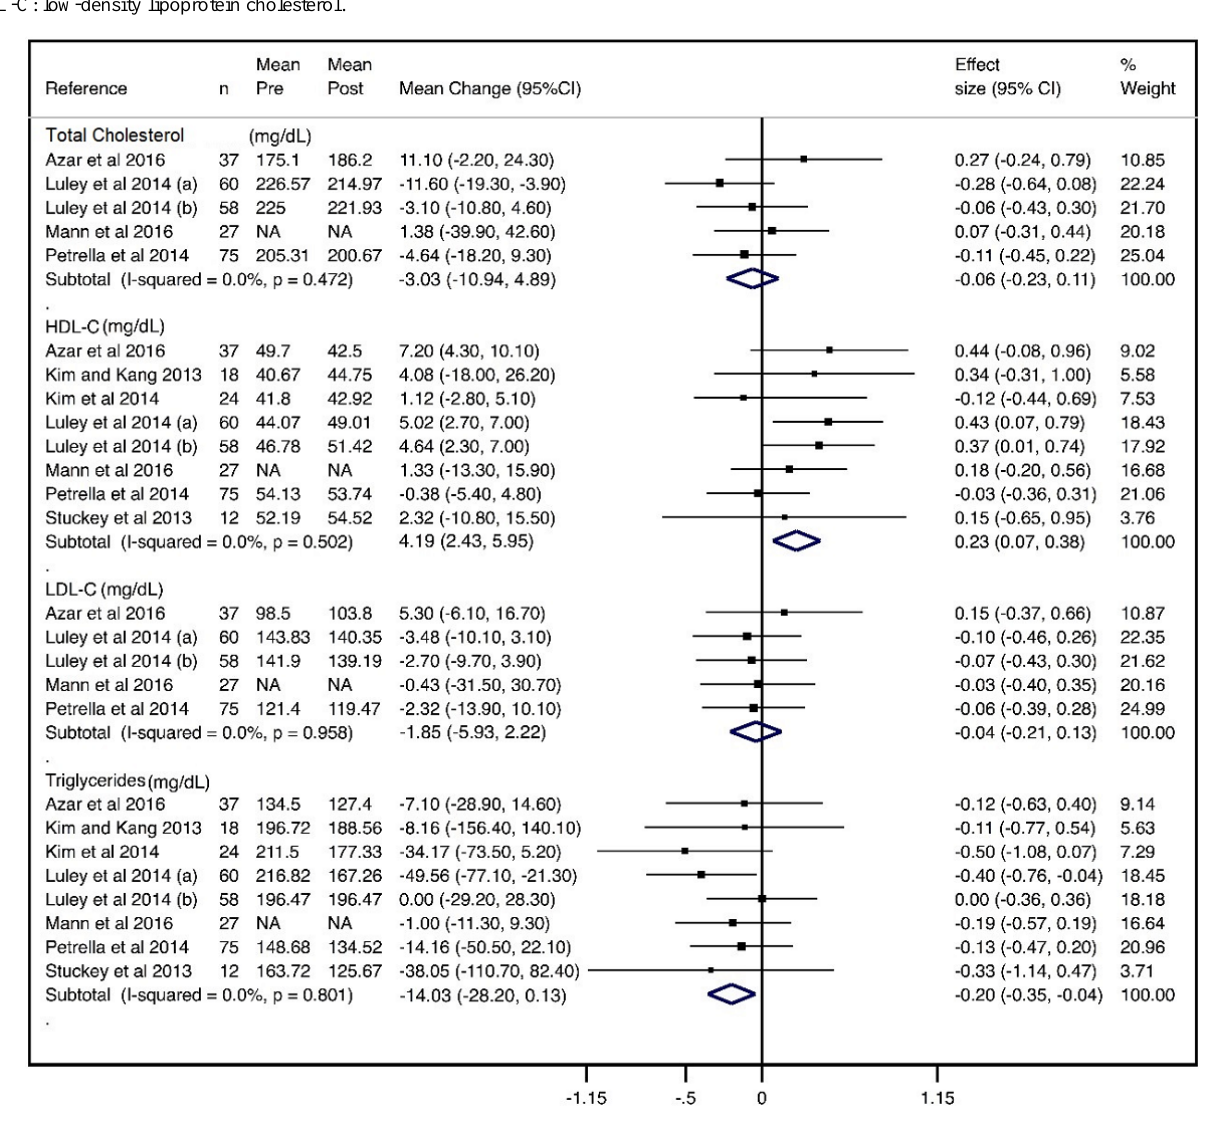
Figure 6. Forest plot of meta-analysis of mean changes and effect sizes for lipid profile parameters. HDL-C: high-density lipoprotein cholesterol; LDL-C: low-density lipoprotein